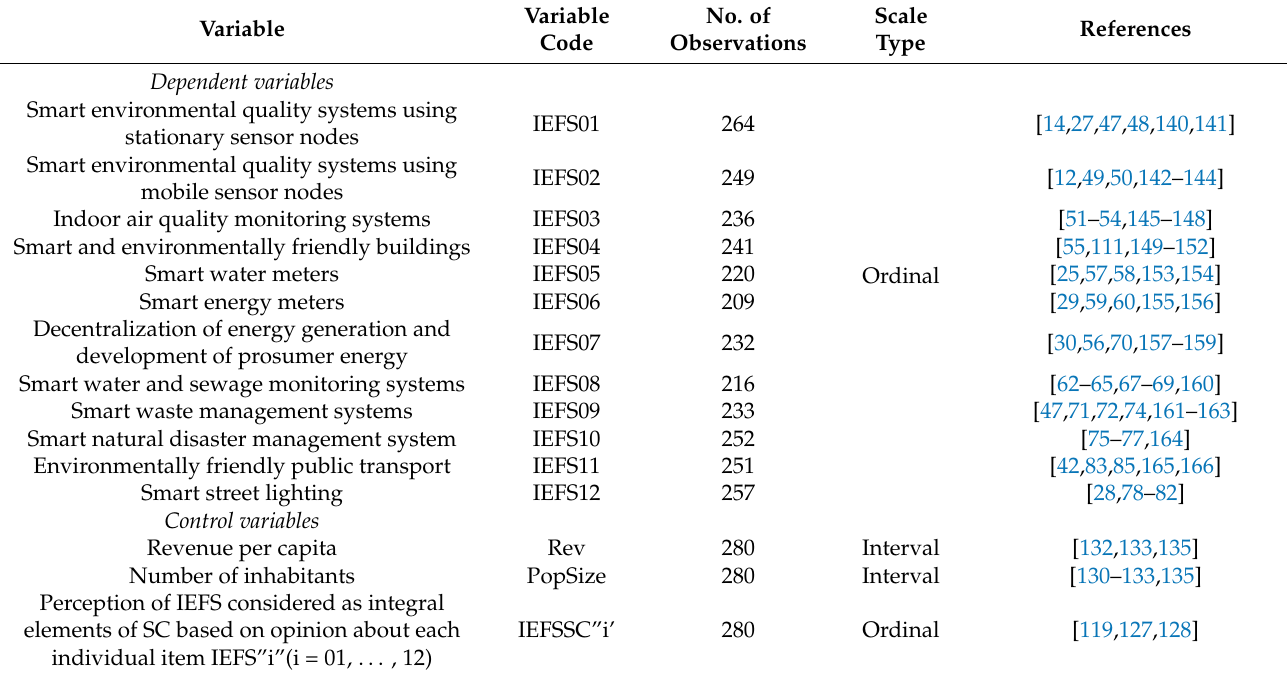
Table 1. Overview of input